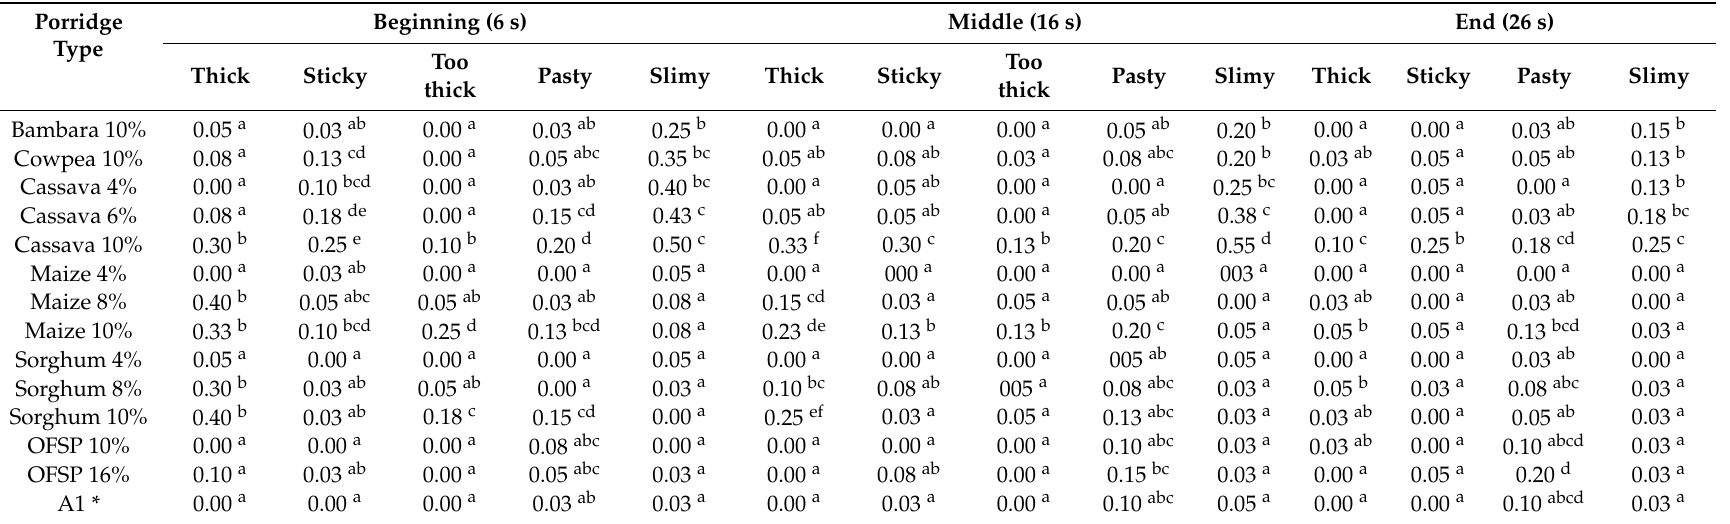
Table 3. The e ff ect of porridge type on the citation proportions for some oral texture attributes at three di ff erent moments during evaluation by a trained Temporal Check-All-That-Apply (TCATA) sensory panel ( n = 10): Data analyzed using Cochran Q test followed by Marascuillo’s pairwise comparison